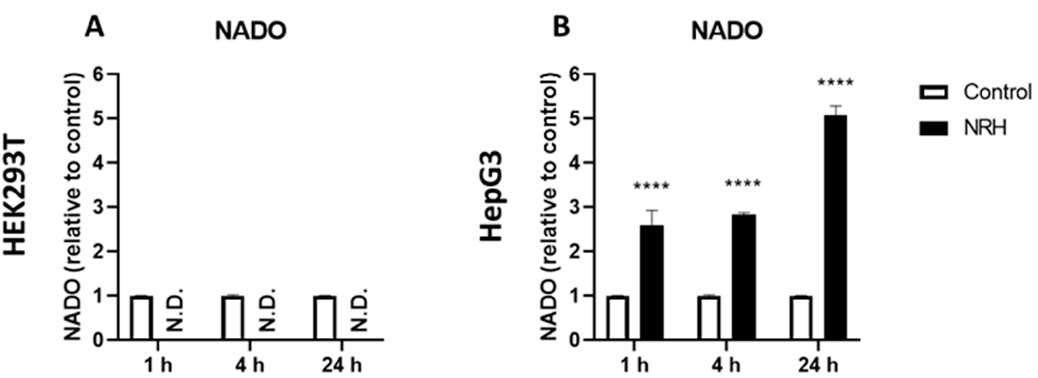
Figure 8. NRH induced 4NADO production in HepG3 cells but not in HEK293T. HEK293T ( A ) and HepG3 ( B ) cells were continuously dosed with 100 µM of 4PYR for 1, 4, and 24 h. The crude cell extract was measured by LC-MS for its NADO content. The NADO detected matches the 4NADO standard. Results are presented as relative abundance to control ± SEM of three inde- pendent experiments. Statistical significance: **** p < 0.0001. N.D: Not Detected.